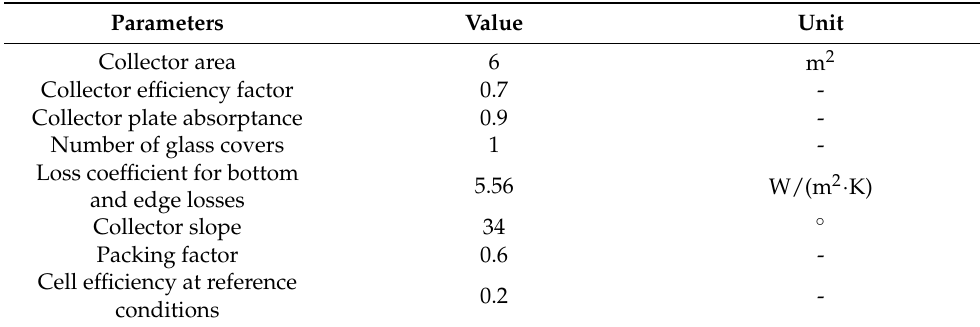
Table 1. PV-T main settings common to all models in